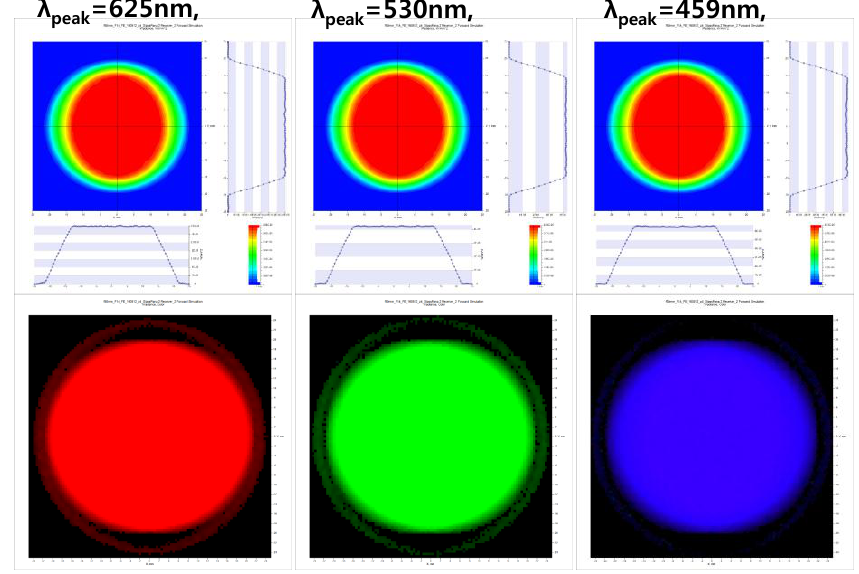
Figure 6. The light intensity distribution profiles on the sample with the red, green, and blue LEDs.